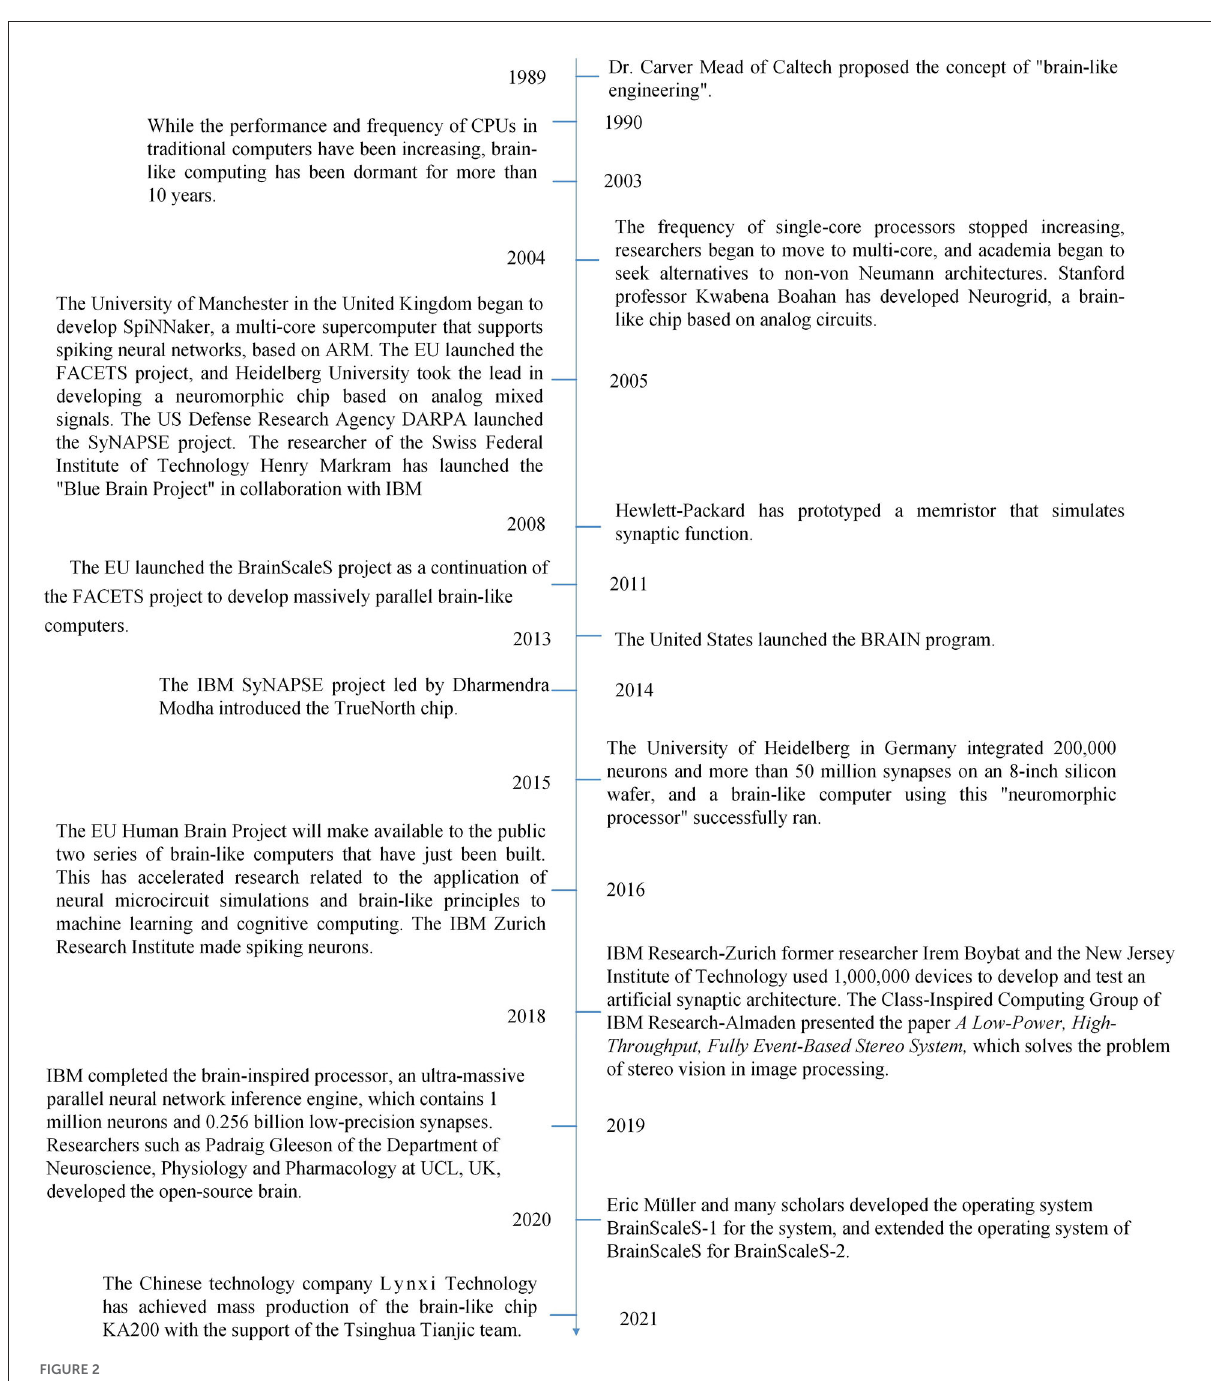
FIGURE2 Brain-like computing has evolved from conceptual advancement to technical hibernation to accelerated development due to the possible end of Moore’s